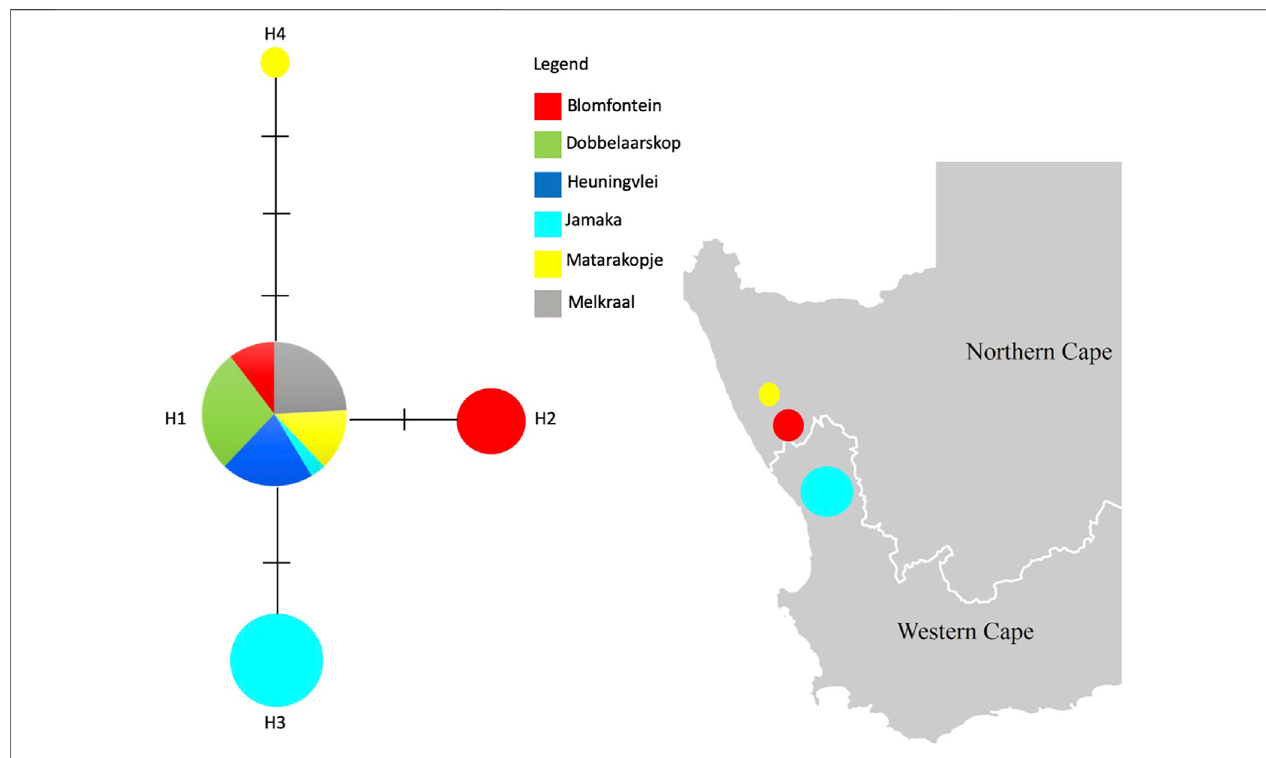
FIGURE 2 | Median-Joining haplotype network based on the chloroplast intergenic trn L UAA F — trn F GAA region for all wild rooibos populations. Dashes on the haplotype network indicate mutations. The haplotypes are shown on the map, respective to the population where they are present.